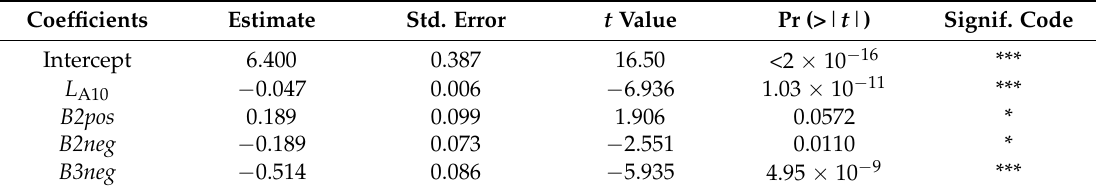
Table 4. Summary of model coefficients’